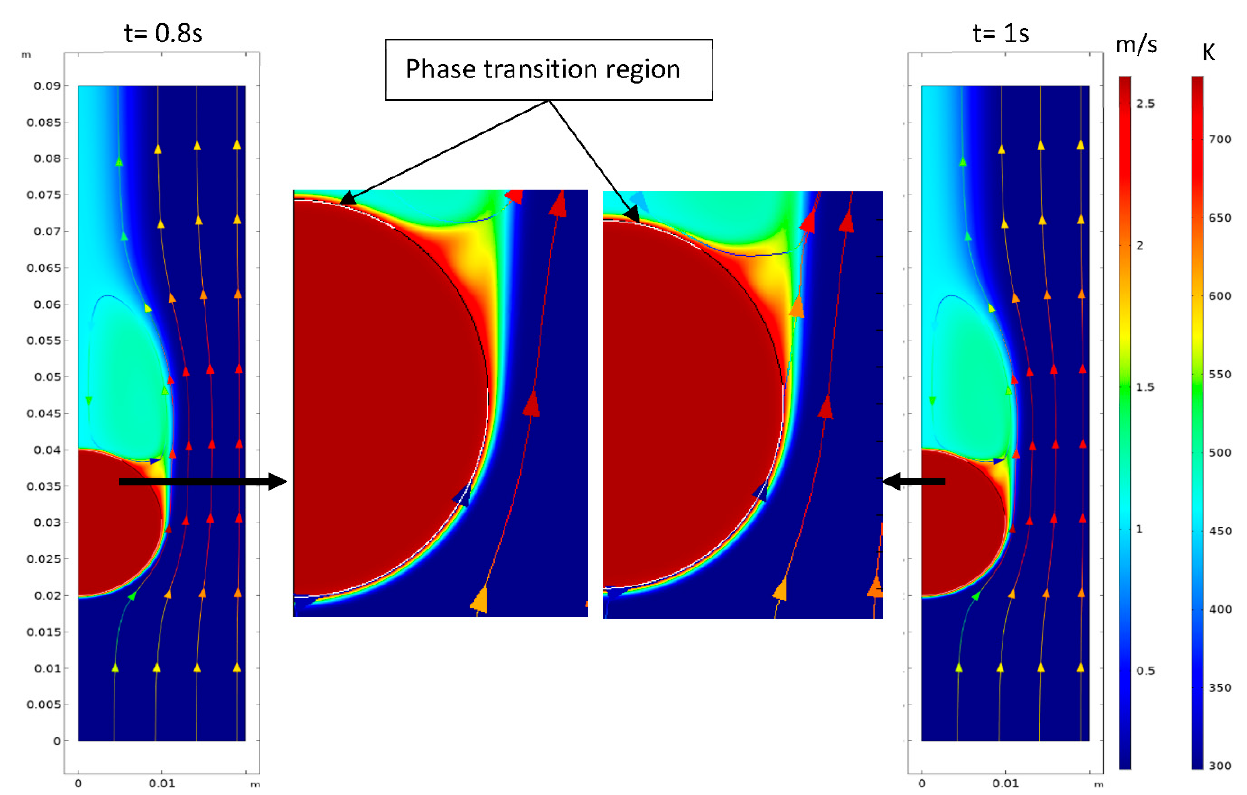
Figure 5. Temperature distribution of N 2 and the droplet (AgCl) domain with a droplet radius of 0.005 m.